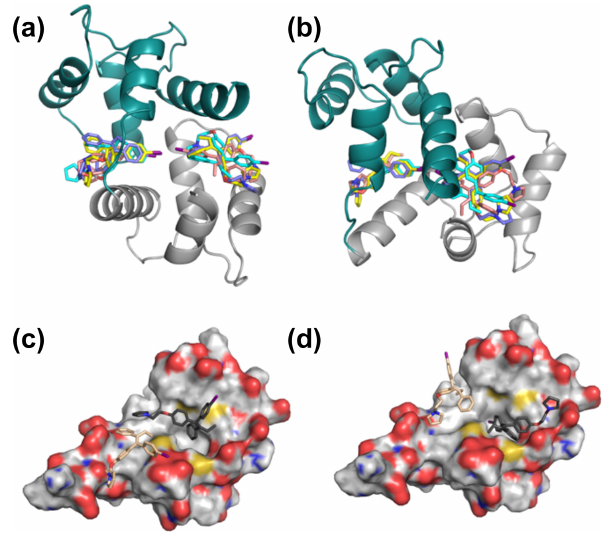
Figure 6. Representative 2 : 1 idoxifene : CaM complex structures. Panels (a) and (b) are orthogonal views of the 2 : 1 idoxifene : CaM complex calculated using NOE-restrained docking of two molecules of idoxifene to CaM coordinates based on the CaM : M13 complex (pdb entry 1cdl). In this calculation, the upper bounds of all observed intermolecular NOEs were set to 5Å. CaM do- mains tr1c and tr2c are coloured green and grey respectively and the idoxifene molecules are coloured in pairs (blue, cyan, yellow, or beige) derived from single calculations. View B is orientated to co- incide with parts C and D. Panels (c) and (d) show the positions of four molecules of idoxifene derived from a single NOE-restrained docking calculation to the tr2c domain of CaM (from pdb entry 1cll), illustrating one arrangement of four conformations that sat- isfy the NOE restraints. The four idoxifene molecules are shown in pairs for clarity only. The two darker-coloured idoxifene molecules have either the phenyl group (c) or the p -iodo-phenyl group (d) by the pocket in the hydrophobic surface of the domain. The lighter- coloured molecules also satisfy NOEs that are within reach of the ligand-binding site associated with the tr1c domain. The surface representation of tr2c is coloured as follows: carbon (grey), nitro- gen (blue), oxygen (red), and sulfur